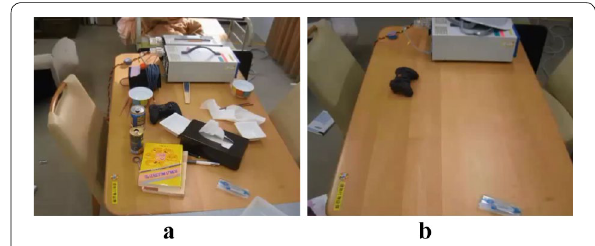
Fig. 8 Tidy up by mock-up [46]. a Before, b